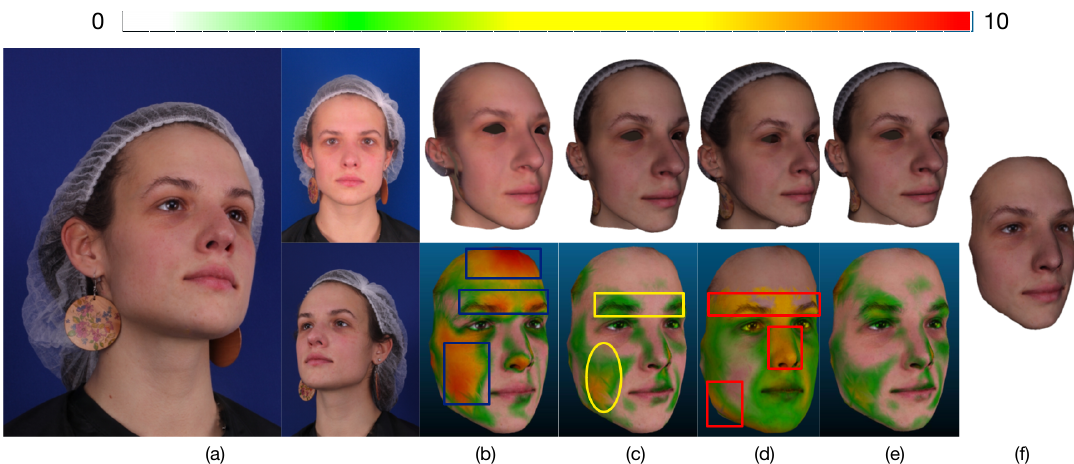
Figure 6. Comparison results. The vertex error (mm) is indicated by color according to the color bar. ( a ) Three viewpoint images. ( b ) Result using method [7] and its comparison result. ( c ) Result using the proposed method without texture constraint and its comparison result. ( d ) Result using the proposed method without feature prior constraint and its comparison result. ( e ) Result using the proposed method with all constraints and its comparison result. ( f ) The ground truth of front